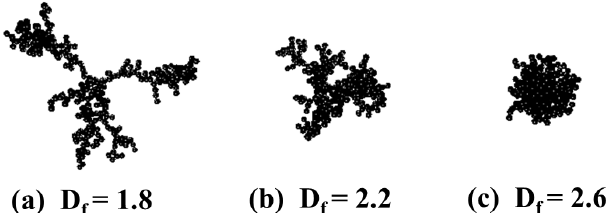
Figure 1. Typical morphologies of fractal